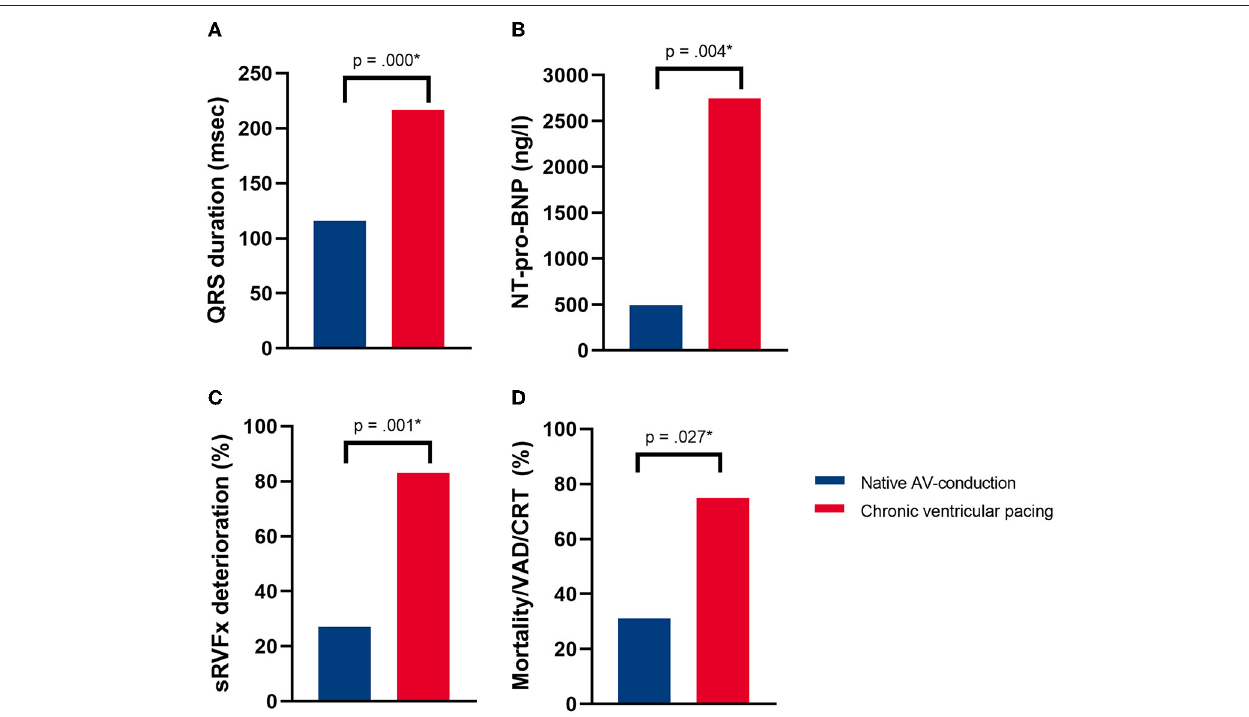
FIGURE 4 | (A) Percentage of patients having reached the composite endpoint of mortality, ventricular assist device (VAD) implantation, or upgrade to cardiac resynchronization therapy (CRT) due to progressive heart failure, (B) QRS duration (ms), (C) N-terminal-pro hormone B-type natriuretic peptide (NT-pro-BNP, ng/L), and (D) the percentage of patients with at least one echocardiographic class of deterioration of sRV function at last follow up after TV surgery in patients with native AV-conduction (blue) vs. chronic left ventricular pacing (red). The * symbol indicates statistically significant